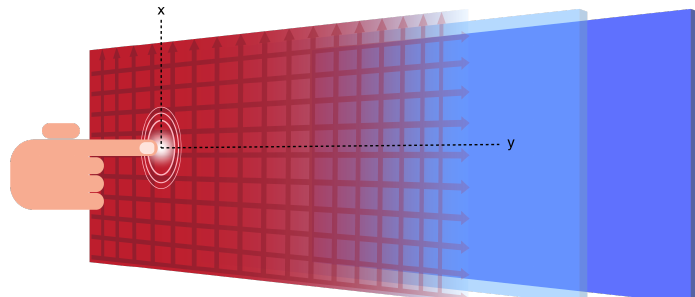
Figure 2. Panel with infrared